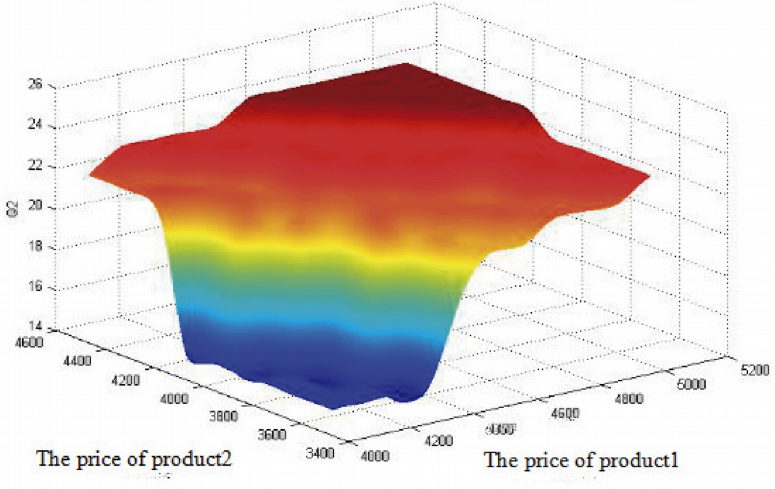
Figure 4. The curve of the total order quantity Q2 that the retailer reserves to Manufacturer 2 before the selling season as Lenovo and Hewlett Packard computer prices change